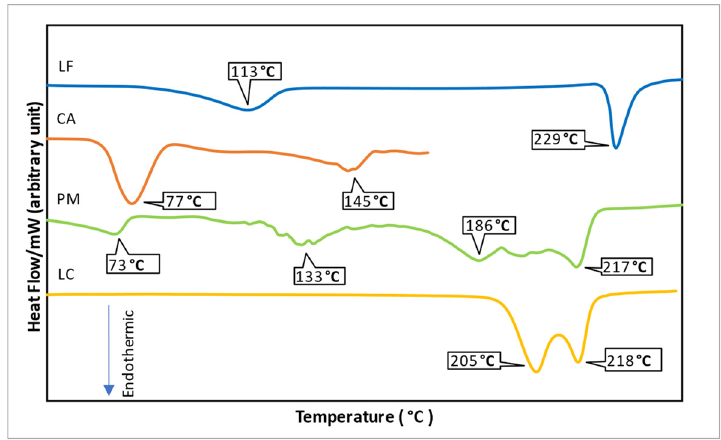
Figure 3. DSC thermogram of levofloxacin-citric acid [59].